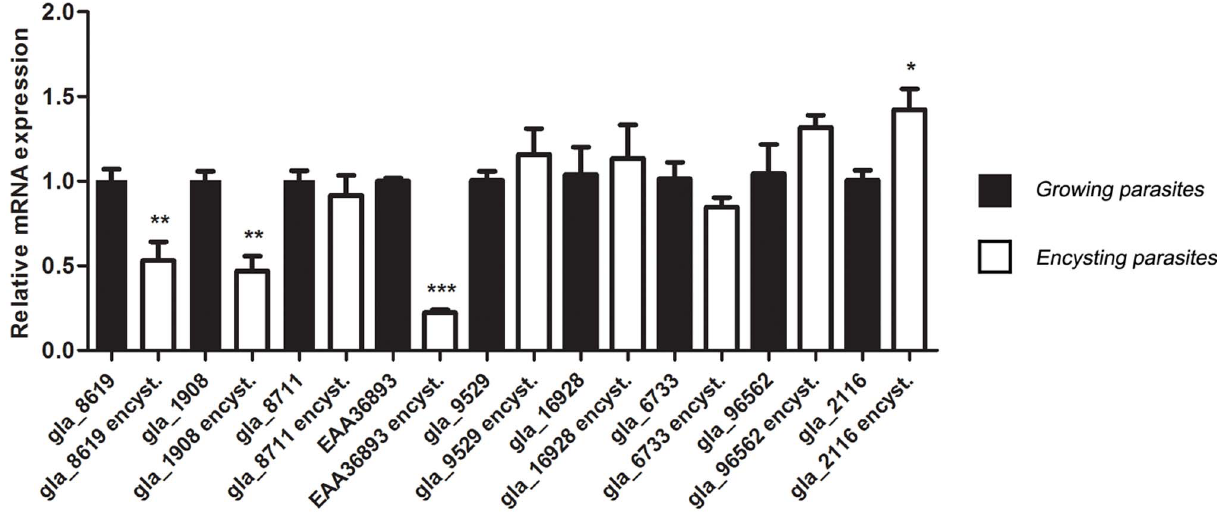
Figure 6. Differential expression of Giardiadhhc genes in growing and encysting parasites. Expression of gla_8619, gla_1908, gla_8711, EAA36893, gla_9529, gla_16928, gla_6733, gla_96562, gla_2116 transcripts from 48 h encysting parasites (white bars) relative to the expression in growing parasites (black bars). The data are the means and SEM of three separate experiments, and each experiment was carried out in triplicate. The qRT-PCR analysis of dhhc genes was performed as described in Methods. The asterisks indicate that there was significant difference compared with growing parasites (Student’s t test: * p , 0.05; **p , 0.01; ***p , 0.001).